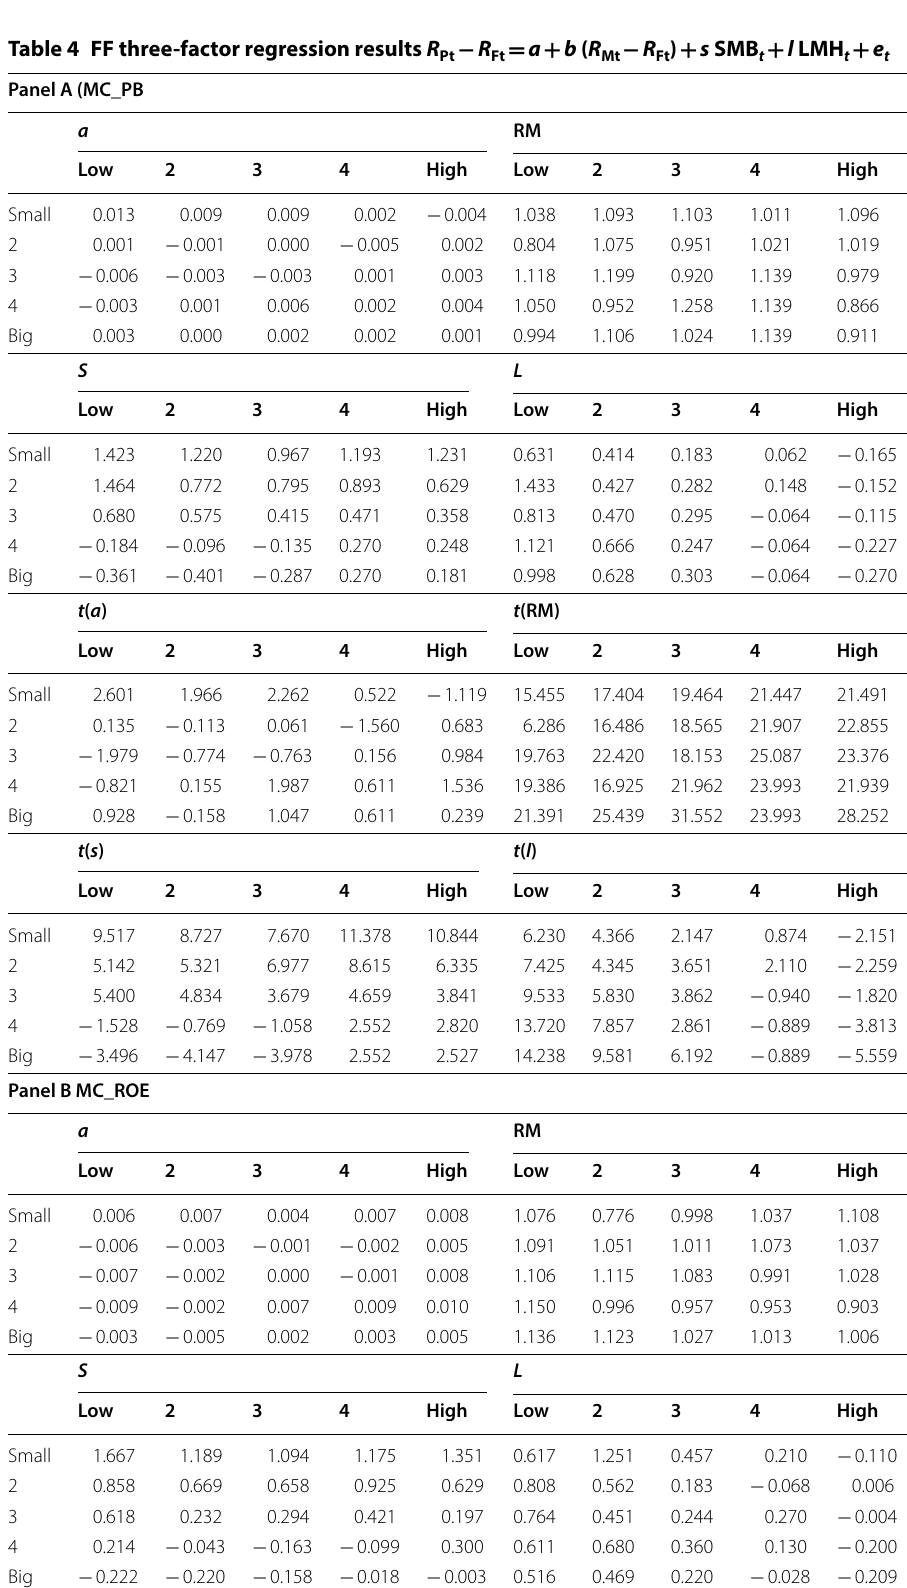
Table 4 FF three-factor regression results R